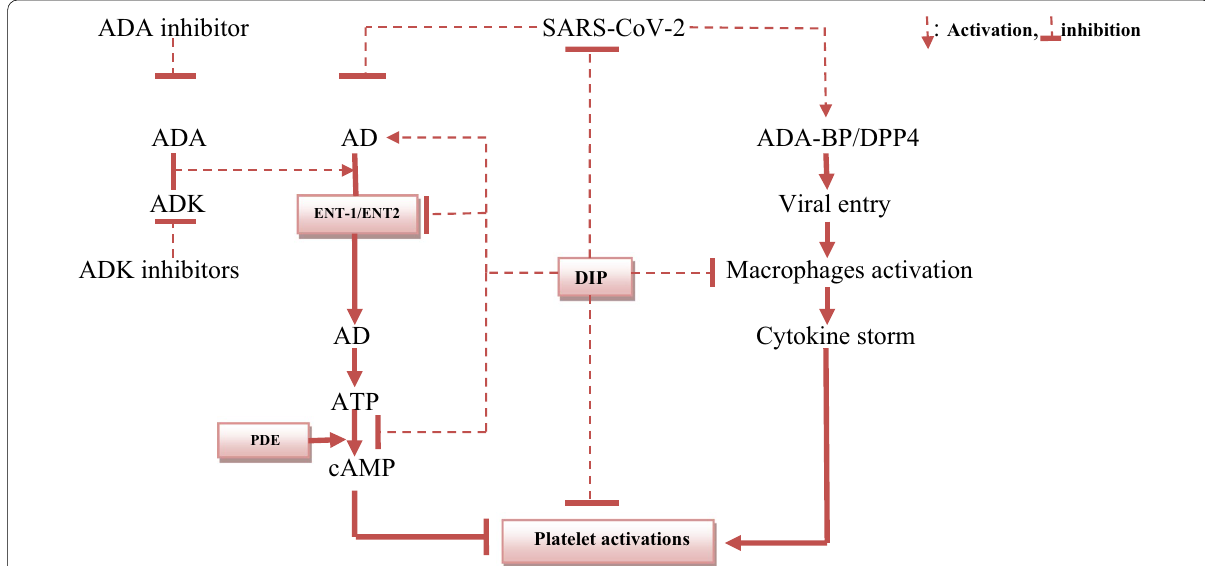
Fig. 1 Adenosinergic pathway and the contribution of DIP in Covid‑19. DIP inhibits SARS‑CoV‑2 replication, platelet activation, PDE, ENT‑1, and macrophages activation with activation of AD. ADK and ADA metabolize AD. SARS‑CoV‑2 activates ADA‑BP on DPP‑4 and inhibits